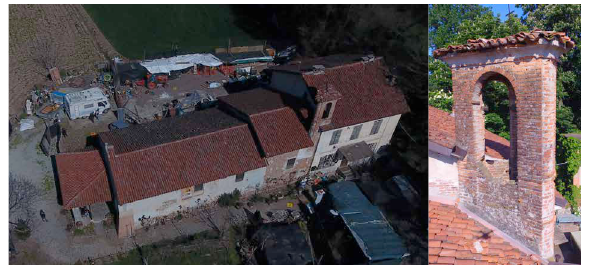
Figure 1 Aerial view of the church (left), belfry (right)